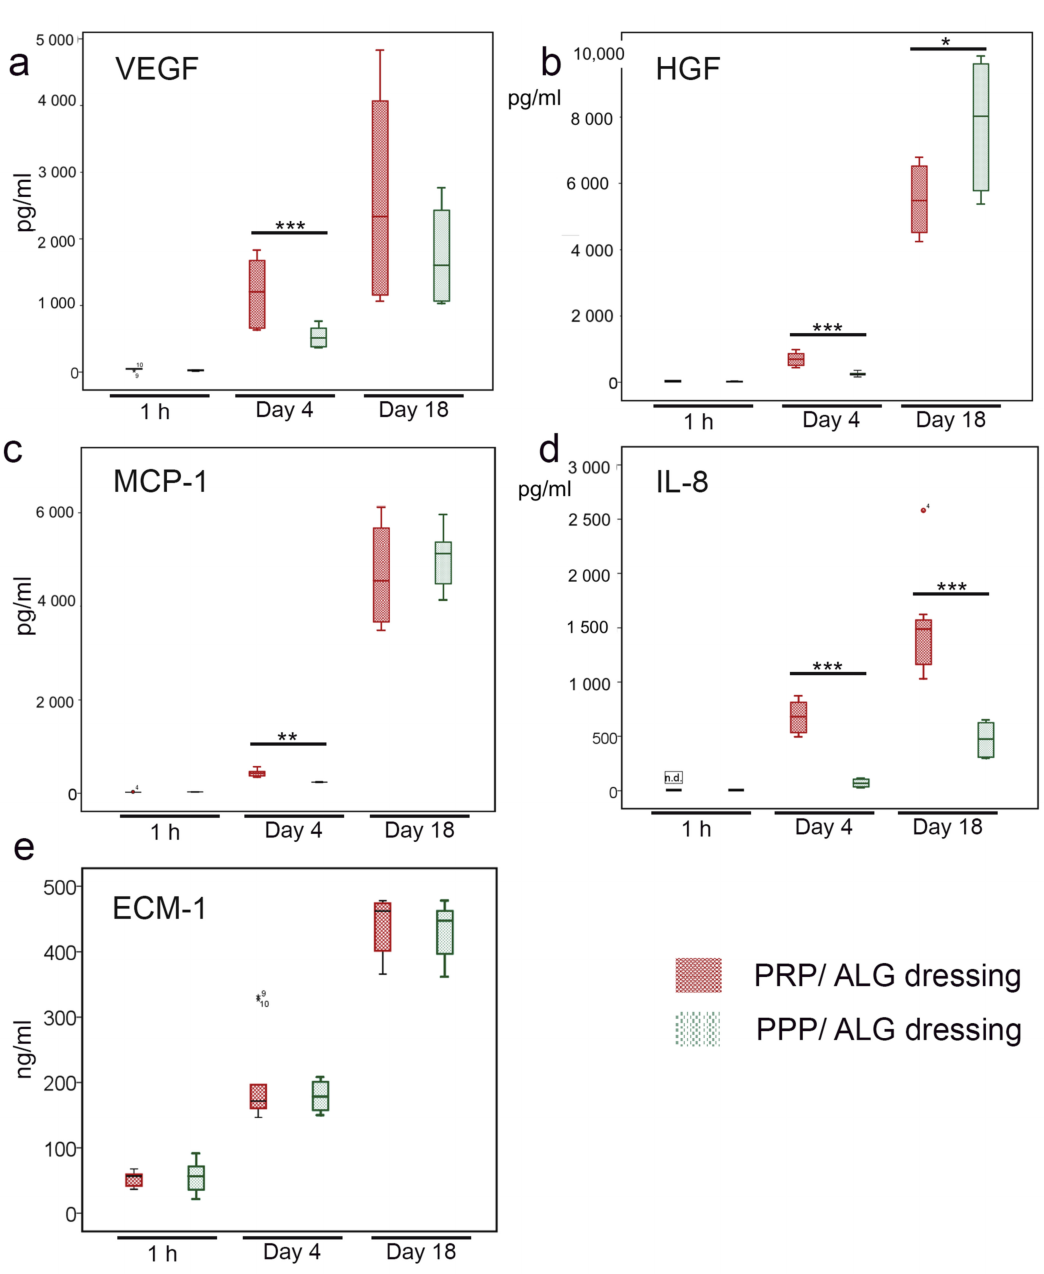
Figure 7. Production/Release of angiogenic and immune modulators by PRP/ALG and PPP/ALG bioprinted dressings at the indicated time points. Box plots showing changes over time (1 h, day 4 and 18) of the median and 25th and 75th percentiles of the released levels of ( a ) VEGF (pg/mL), ( b ) HGF (pg/mL), ( c ) MCP-1 (pg/mL), ( d ) IL-8 (pg/mL), and ( e ) ECM-1 (ng/mL). * p < 0.05; ** p < 0.01; *** p < 0.001. ALG, alginate; PRP, platelet-rich plasma; PPP, platelet-poor plasma; VEGF, vascular endothelial growth factor; HGF, hepatocyte growth factor; MCP-1, monocyte chemotactic protein 1; IL-8, interleukin-8; ECM-1, extracellular matrix protein